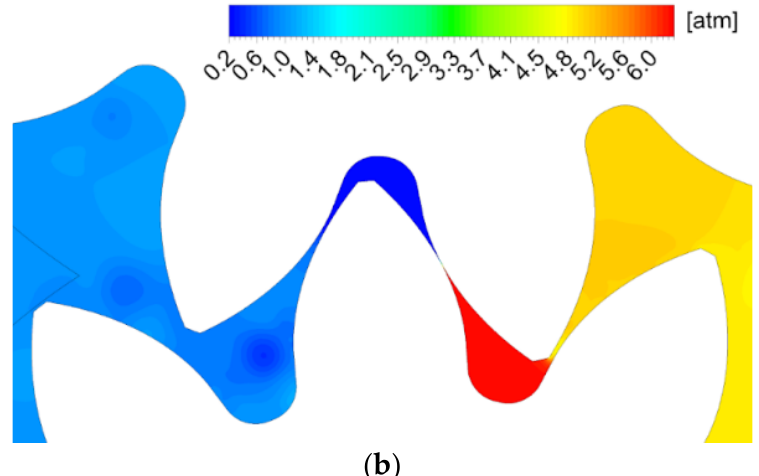
Figure 9. Position e: experimental result [18] picture 3.12; ( a ) velocity field (CFD); ( b ) pressure field (CFD).